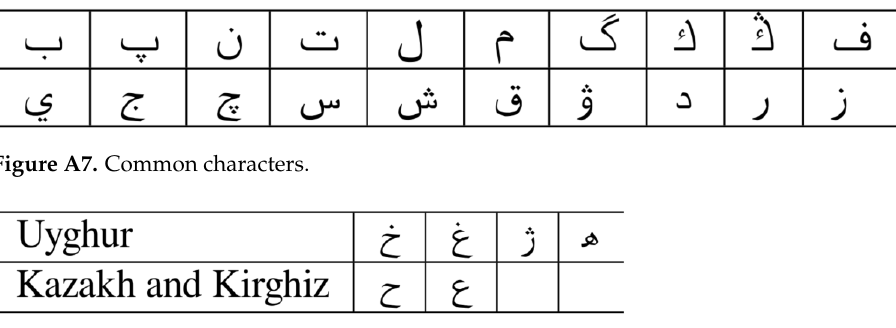
Figure A8. Different